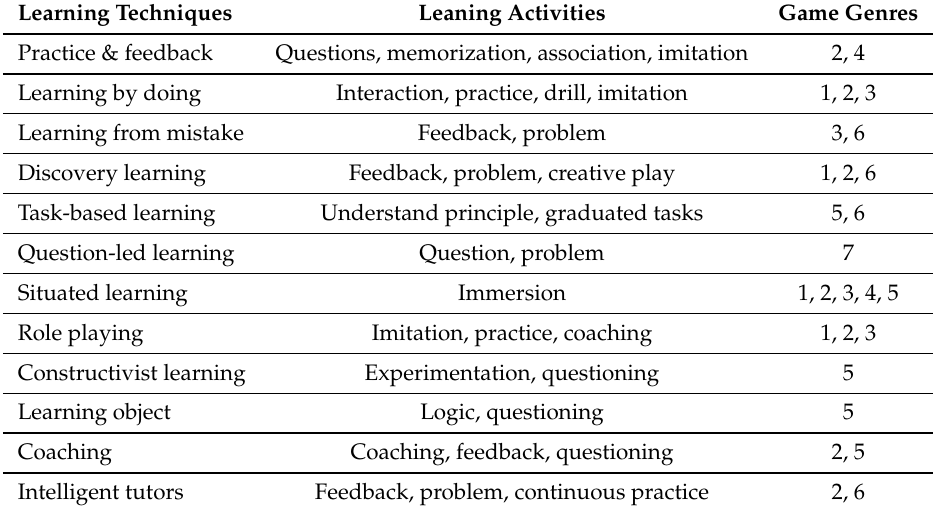
Table 2. Relationship between learning techniques, learning activities, and game genres (adapted from